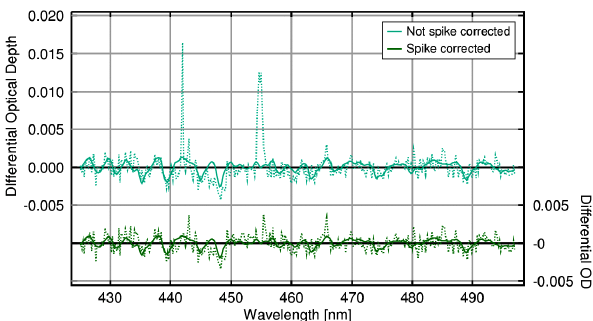
Fig. 9. Example for a fit in the Southern Atlantic Anomaly re- gion affected by spikes. Shown are the scaled differential cross- section (solid lines) and the sum of scaled cross-section and resid- ual (dotted lines). The original retrieval is shown in the upper part and the retrieval after spike removal in the lower part of the figure. The retrieved NO 2 slant columns are 9.3 × 10 15 and 6.9 × 10 15 moleccm − 2 without and with spike correction, respec-